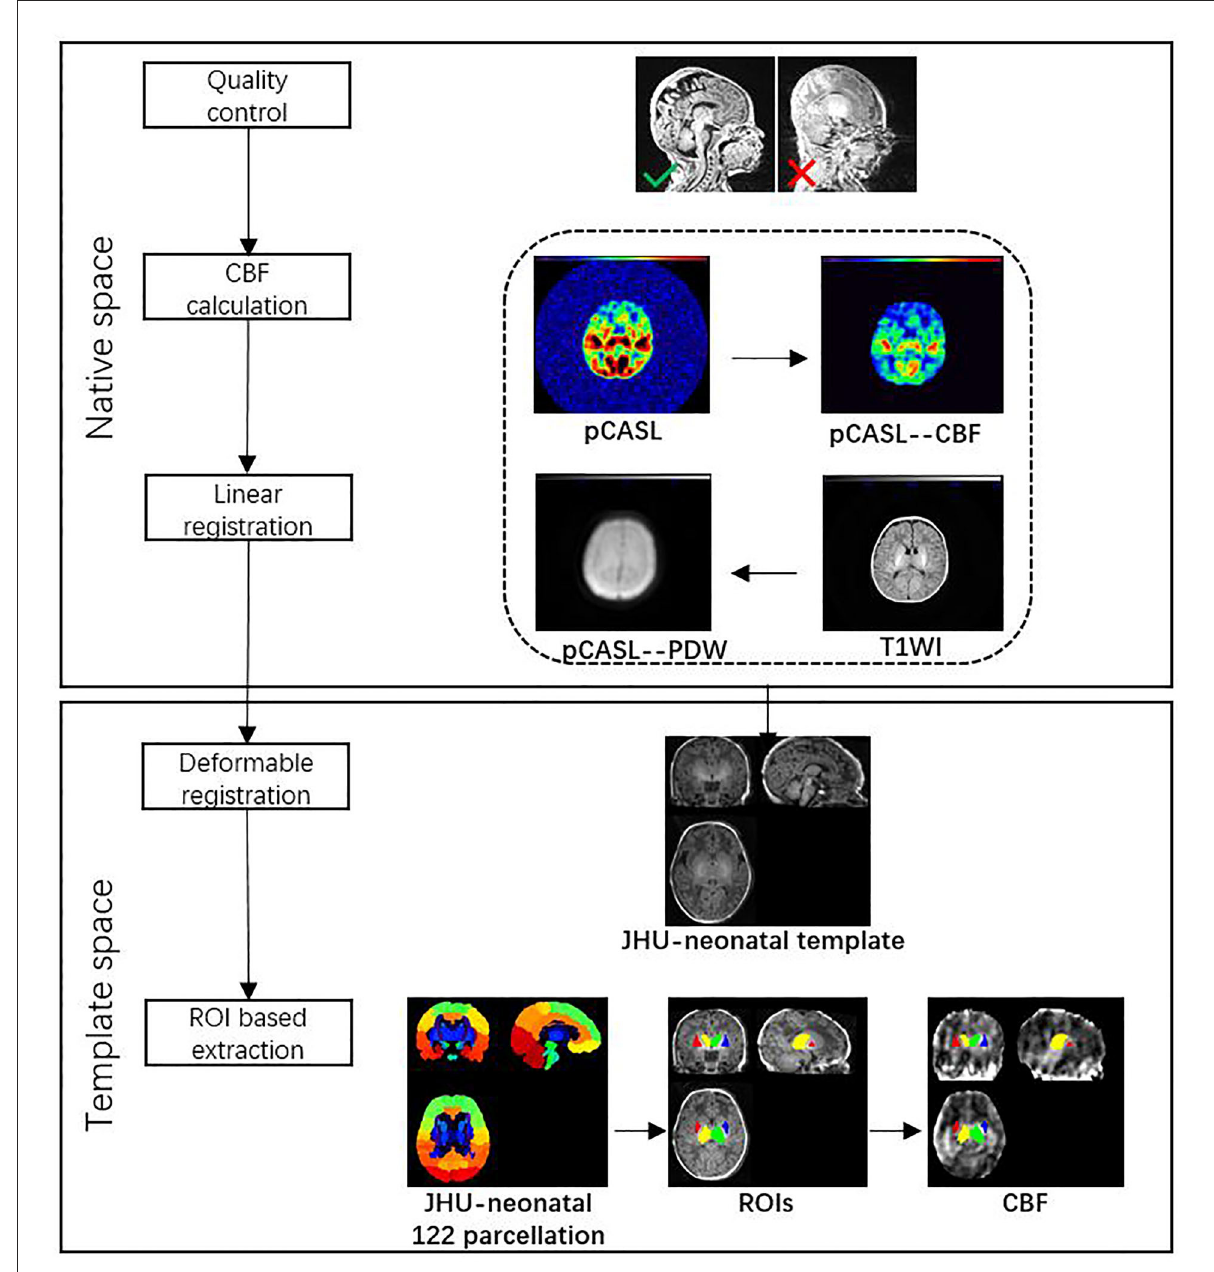
FIGURE1 Data analysis pipeline.